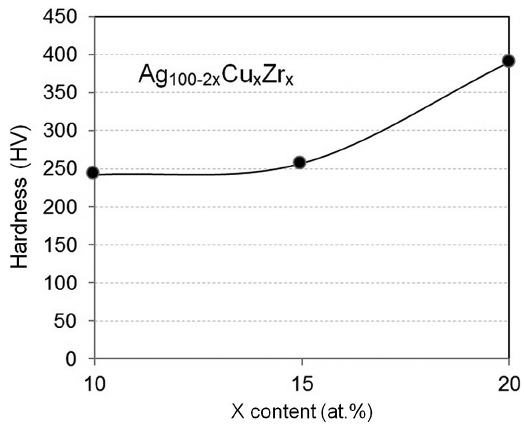
Figure 8. Vickers hardness of Ag where x = 10, 15 and 20